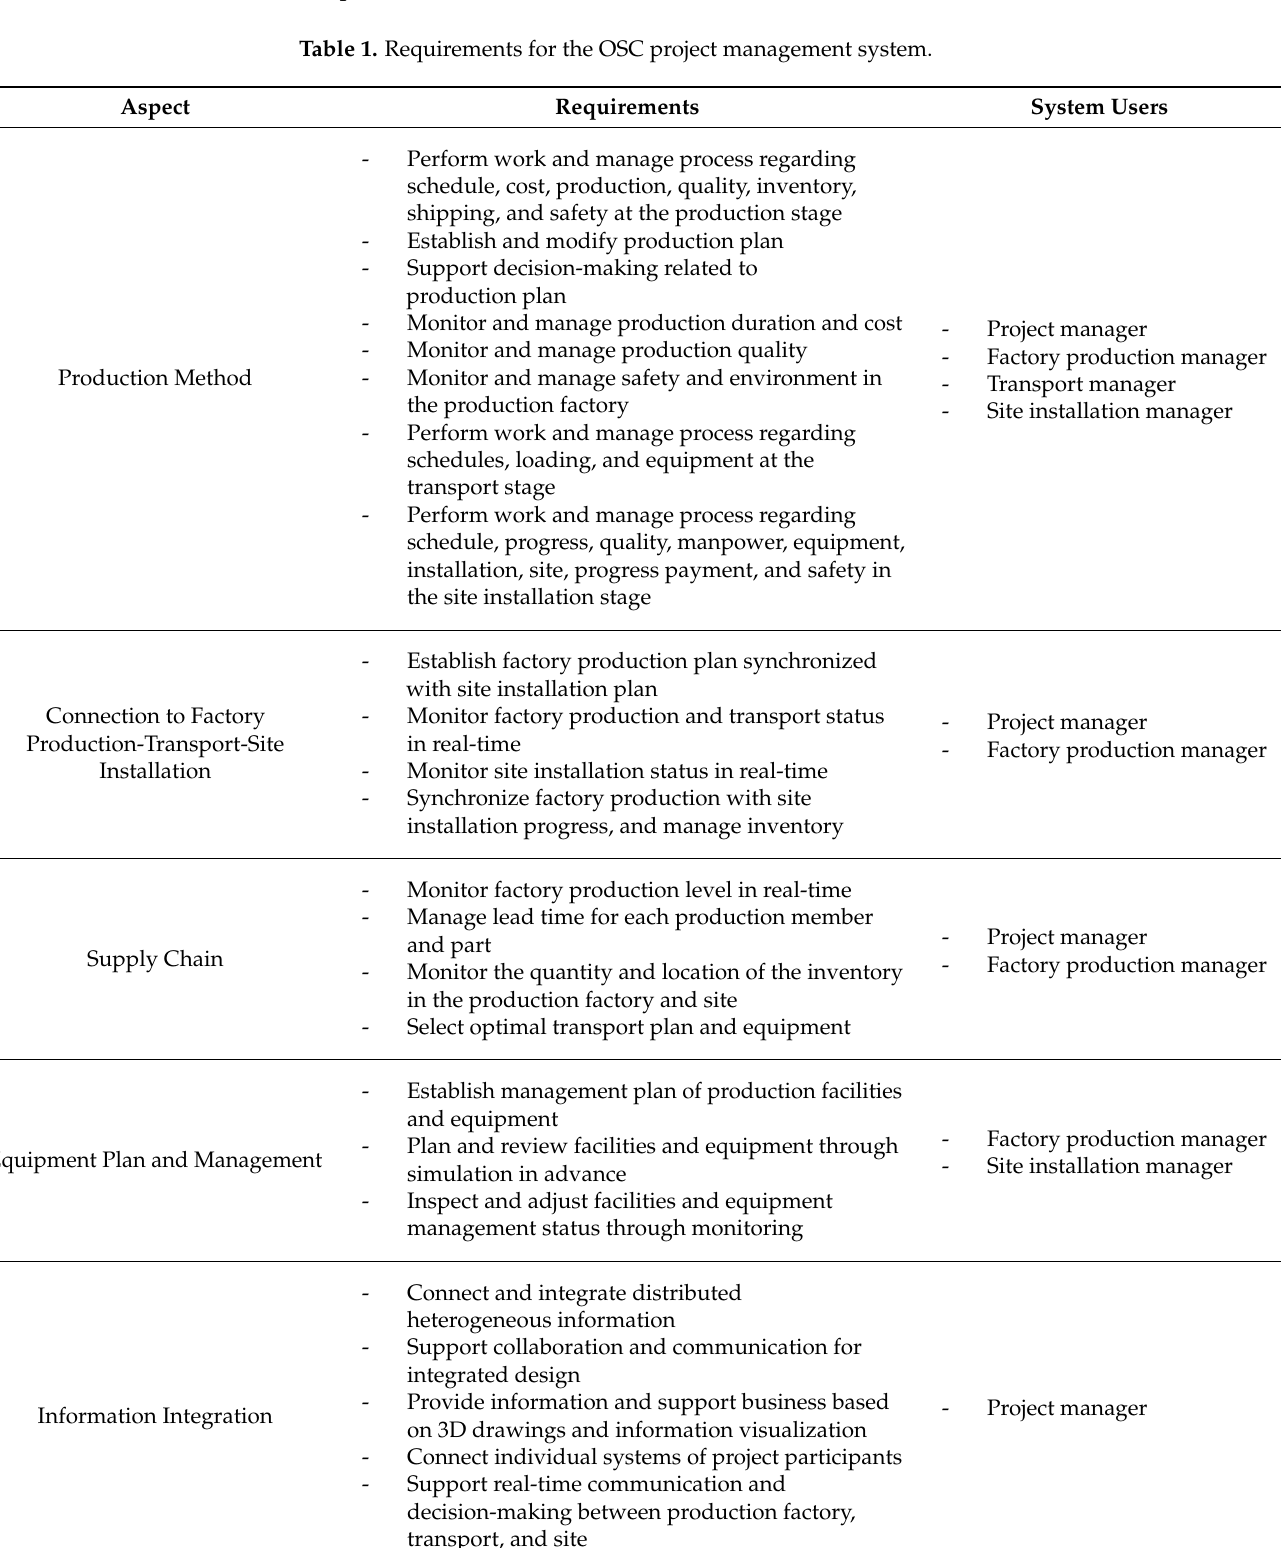
Table 1. Requirements for the OSC project management